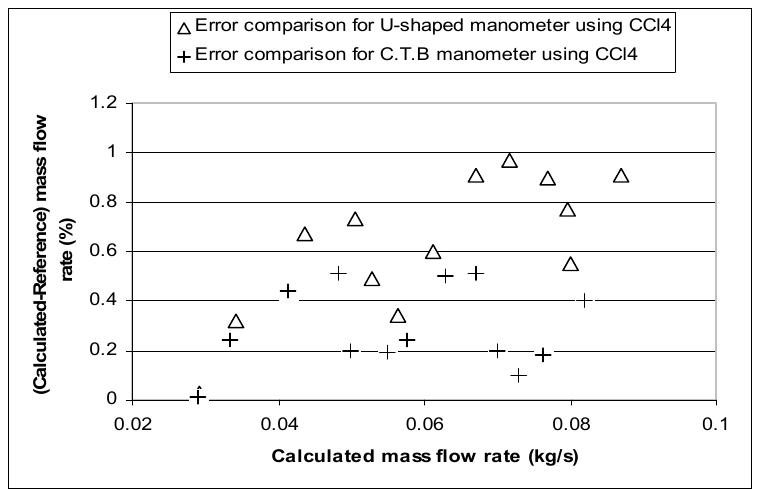
Figure 8. Error analysis comparison between mass flow rates in case of orifice meter while using CCl